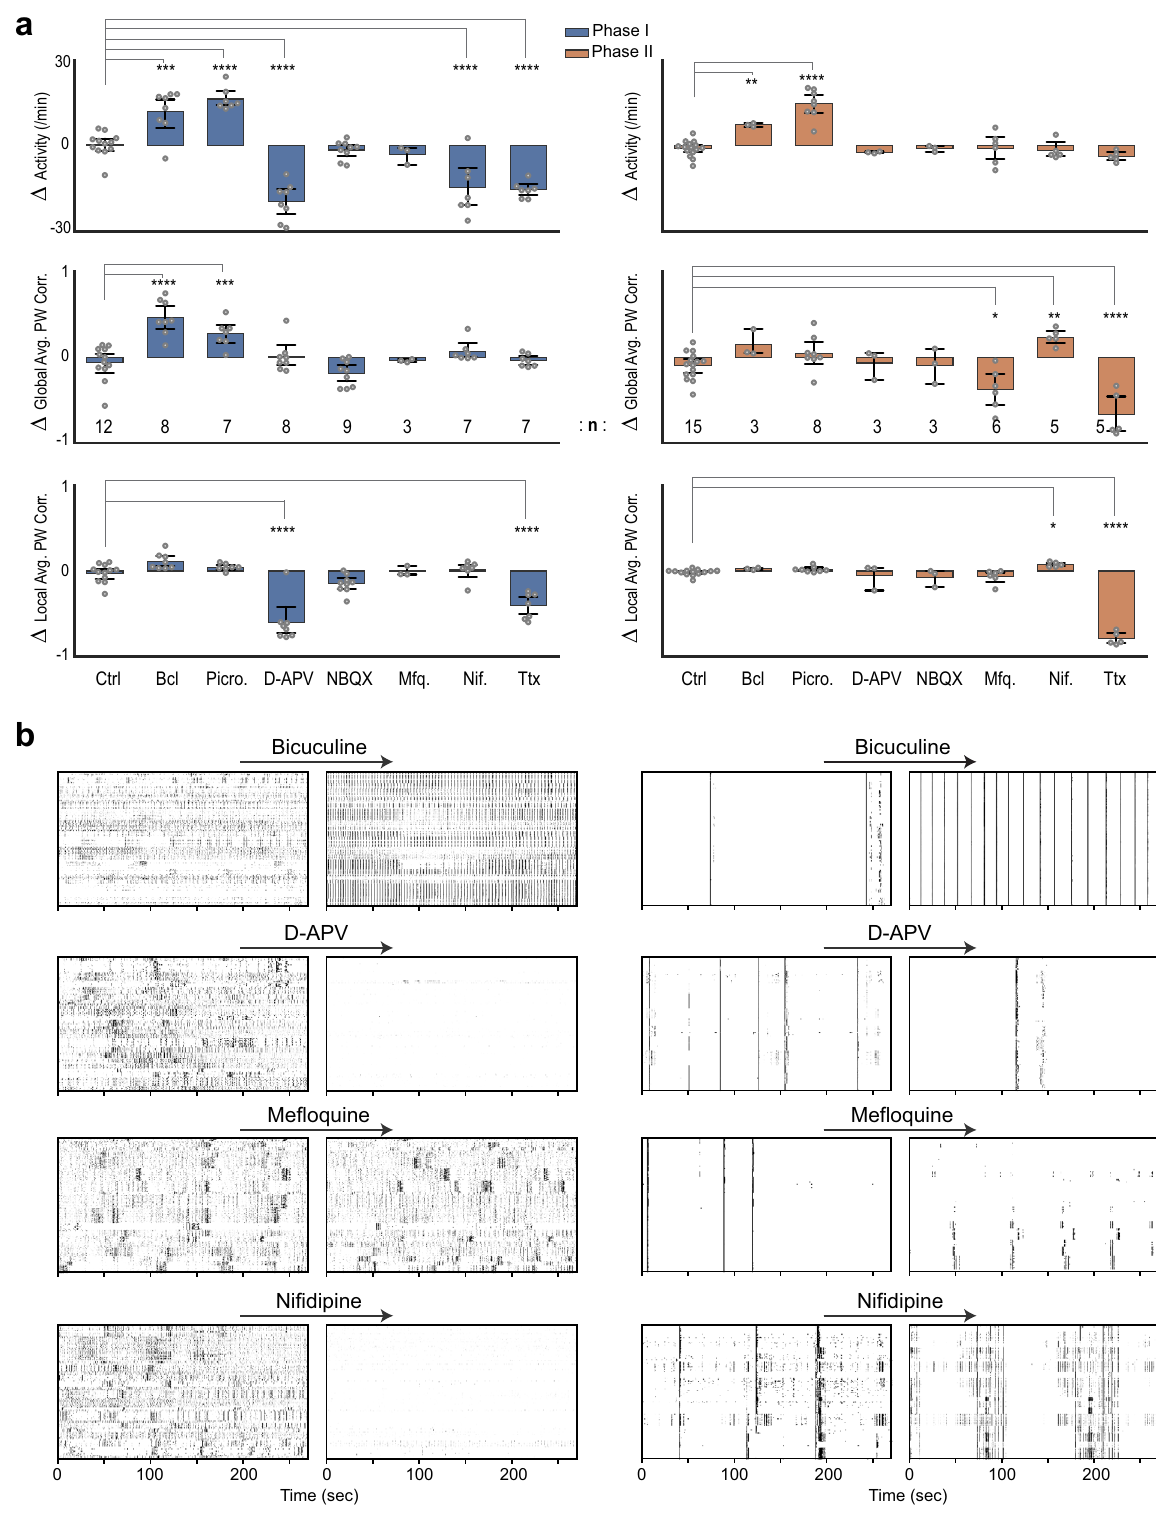
average pairwise co-activity (Fig. 2 and Supplementary Figs. 4 – 6 and Videos 5, 6). To mitigate the sample-to-sample variabilities, effect of pharmacological treatments was quanti fi ed relative to the baseline values in the exact same samples (Fig. 2a, Δ = after — before